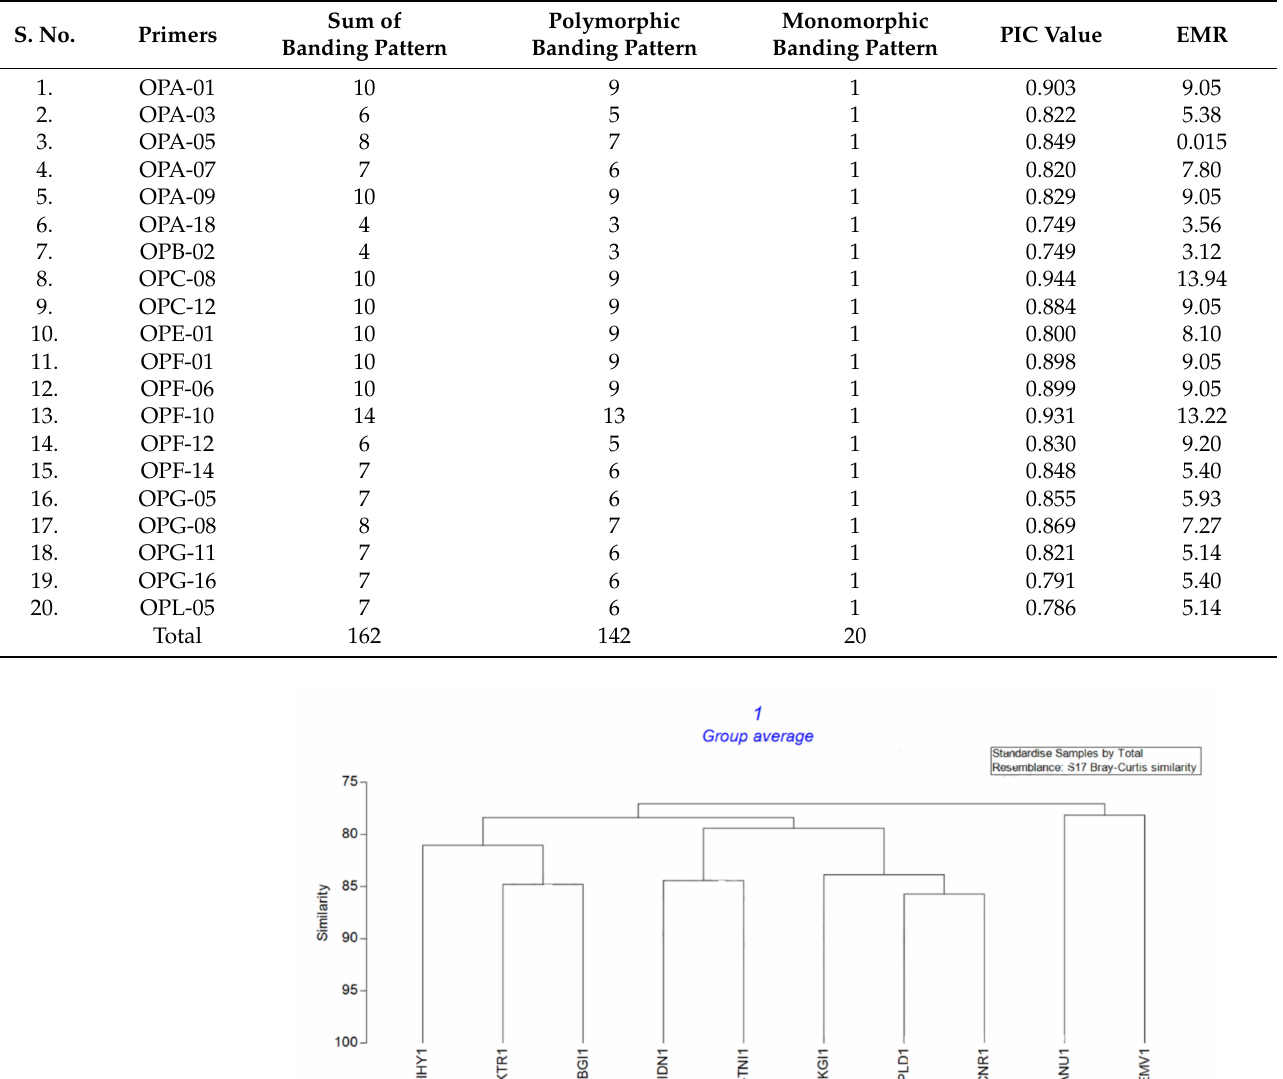
Table 2. Genetic diversity of the isolates of E. pisi revealed by RAPD analysis.